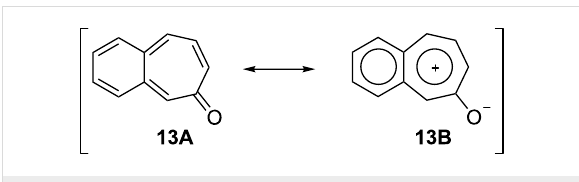
photochemical behavior of 230 depended on the state of the ir- radiation medium. For example, the smooth [ π 10 + π 10] dimer- ization of 13 to give dimeric product 233 was realized with the irradiation (>420 nm) of 13 in a fluid EPA solution below − 100 °C [154]. Furthermore, the IR spectra of 3,4-benzotro- pone ( 13 ) generated in matrices at 13 K by the photoisomeriza- tion of 230 were directly observed [156]. In addition, the